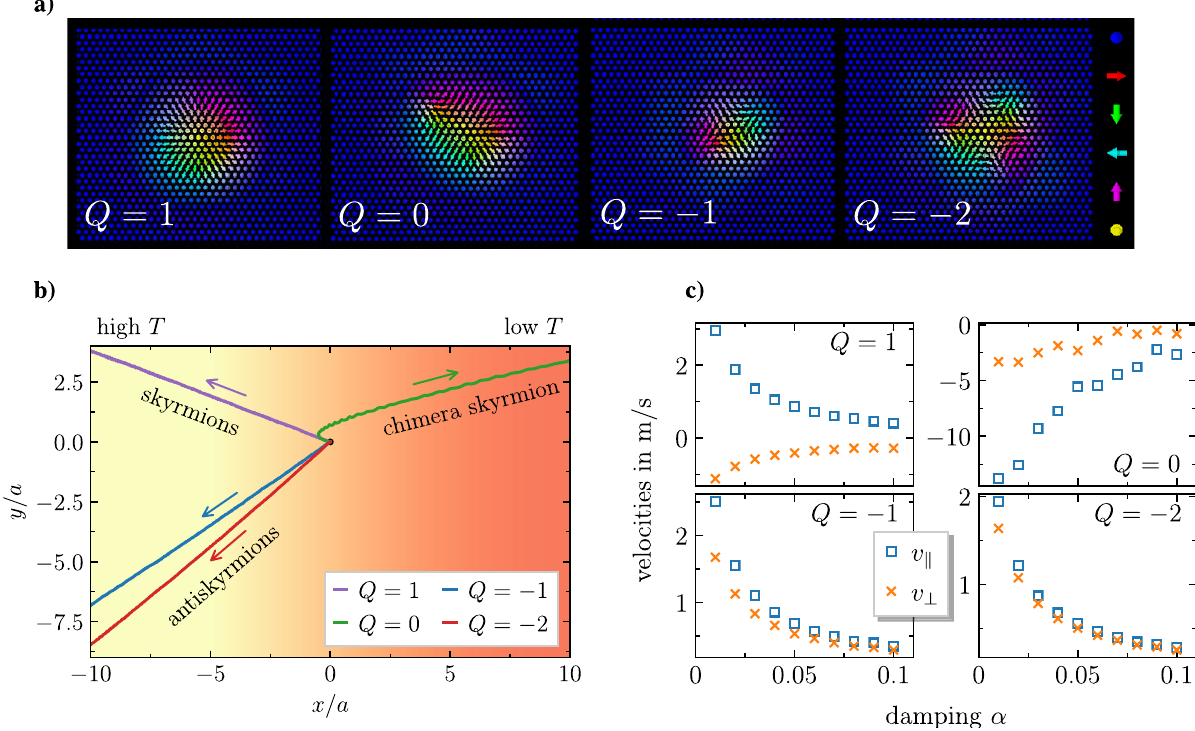
Figure 1. Topology dependence of the skyrmion Seebeck and skyrmion Nernst effect. ( a ) Equilibrium spin configurations of skyrmionic spin structures in (Pt 0.95 /Ir 0.05 )/Fe/Pd(111) with topological charges as labeled. The colors indicate the orientation of the spin vectors. ( b ) Averaged trajectories for the dynamics of skyrmionic spin structures with different topological charges in a temperature gradient ∇ T � − e x with α = 0.01 . Arrows indicate the direction of motion. ( c ) Velocities parallel and perpendicular to the direction of the temperature gradient for skyrmionic spin structures with different topological